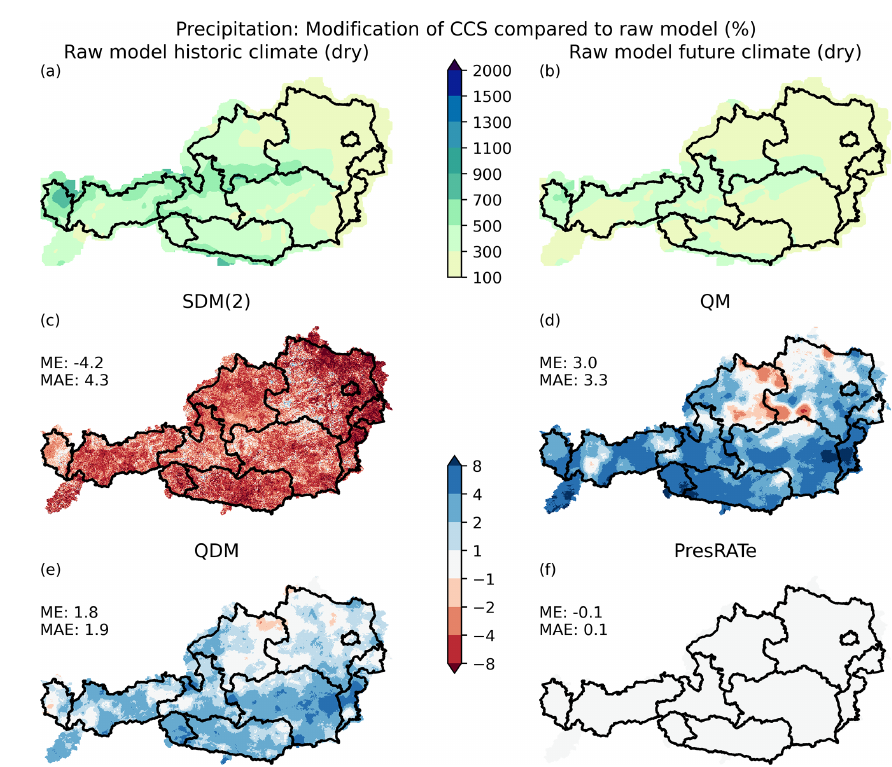
Figure 6. Error of CCS compared to CCS of raw model (Eq. 9). (a) Raw model annual precipitation in historic period (mm). (b) Raw model annual precipitation in future period (mm). (c) SDM, (d) QM, (e) QDM of the CCS and (f) PresRATe. A perfect bias adjustment equals